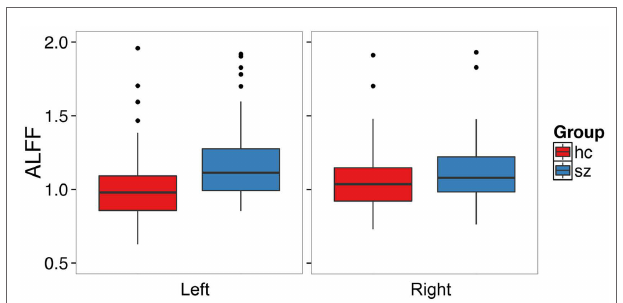
Figure 1 | Patients with schizophrenia have increased amplitude of low frequency fluctuations in the left hippocampus . The boxplots show the median, interquartile range, and outliers. The whiskers extend to the lowest value within 1.5 times the